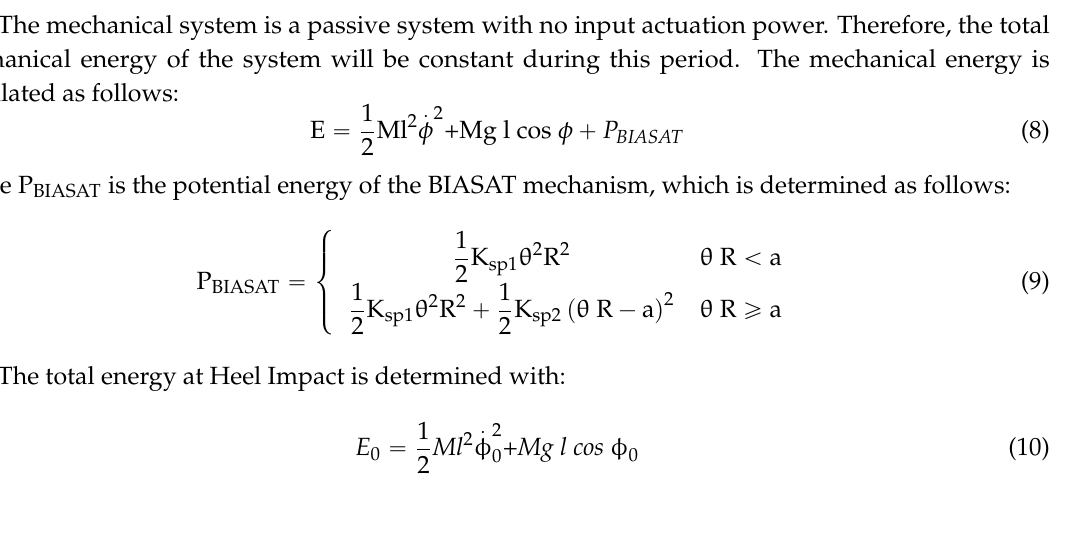
Figure 16. Modeling of the Heel Impact phase with the action and reaction force on the hip